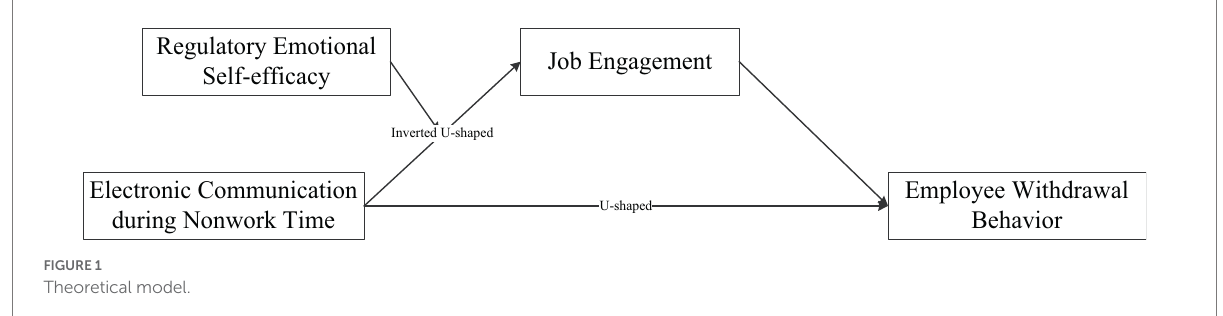
FIGURE 1 Theoretical